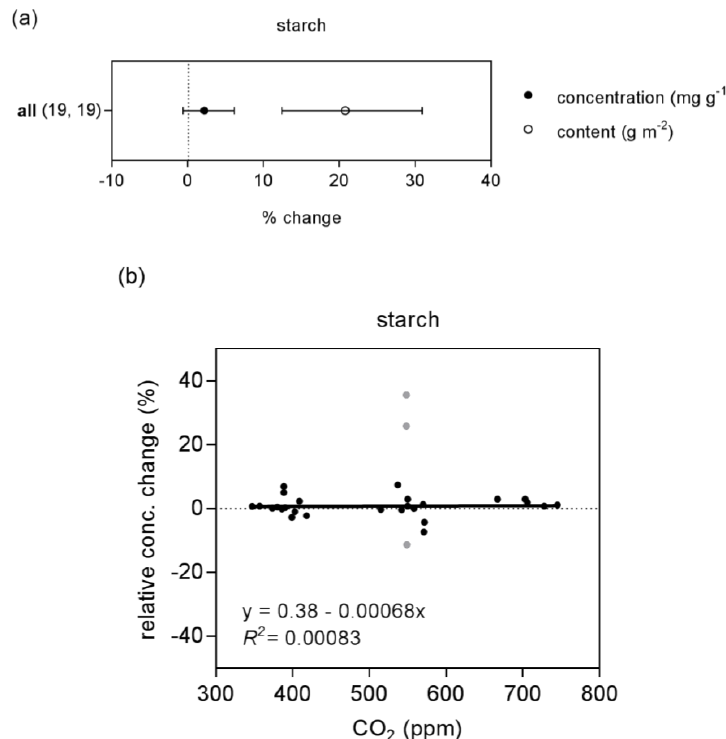
Figure 3. ( a ) Meta-analysis of eCO 2 effects on starch concentration and content using ambient CO 2 as a reference. Number of comparisons for concentration and content, respectively, are given within brackets. ( b ) Response function for starch concentration (relative to 350 ppm) with CO 2 . Grey markers show data points identified as outliers and that were not included in the curve